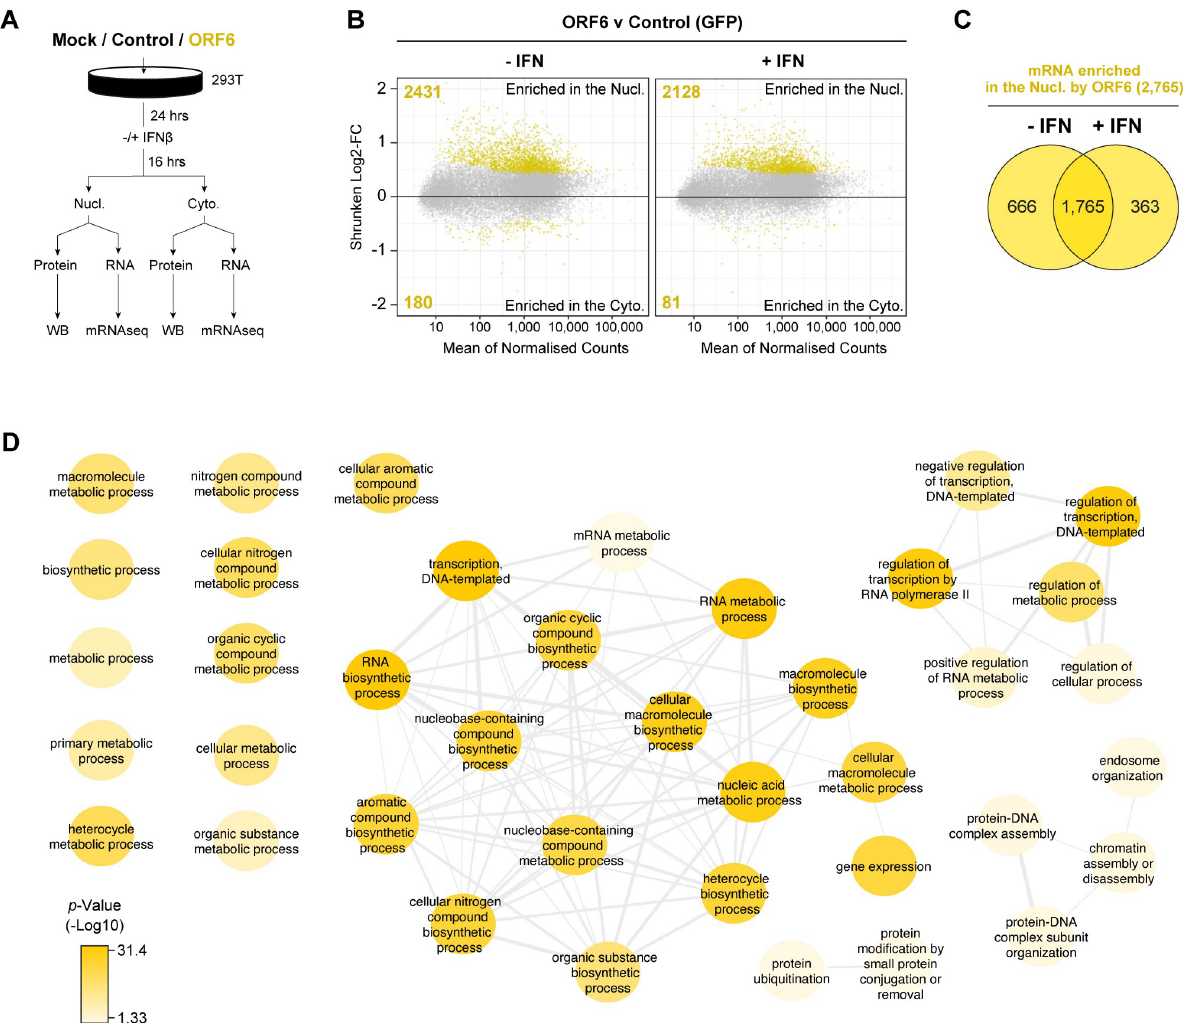
Fig 3. ORF6 inhibits the nuclear export of cellular mRNA. HEK293T cells were transfected with pLVX-EF1 α -GFP or pLVX-EF1 α -ORF6 or left untransfected (mock). After 24h, cells were either treated with IFN- β (1,000 units/ml) for 16h or left untreated. Cells were then harvested and fractionated into nuclear (Nucl) and cytoplasmic (Cyto) fractions. Cells were either lysed for immunoblot analysis (see S4A Fig) or RNA was extracted for mRNAseq. (A) Schematic of experiment design. (B) The log2-fold change (Log2-FC) in mRNA abundance was calculated between the Nucl and Cyto fractions for both GFP and ORF6 expressing cells, without and with IFN treatment (see S4B Fig). The log2-FC in mRNA abundance was then directly compared between ORF6 and GFP, without (left panel) and with (right panel) IFN, to determine which mRNAs were specifically enriched in the nucleus or cytoplasm by ORF6. The log-2FC was weighted against the adjusted p -value (shrunken Log2-FC) to show significantly enriched mRNAs (yellow points). The number of mRNAs significantly enriched is shown. The mRNA count was normalised and averaged between the three biological repeats. (C) Venn diagram of the number of mRNAs that were significantly enriched in the nucleus by ORF6 with and without IFN. (D) mRNAs significantly enriched by ORF6 without IFN treatment were analysed for enriched GO terms, which were filtered and mapped using the REVIGO tool. Highly similar GO terms are grouped and linked. Colour intensity reflects significance